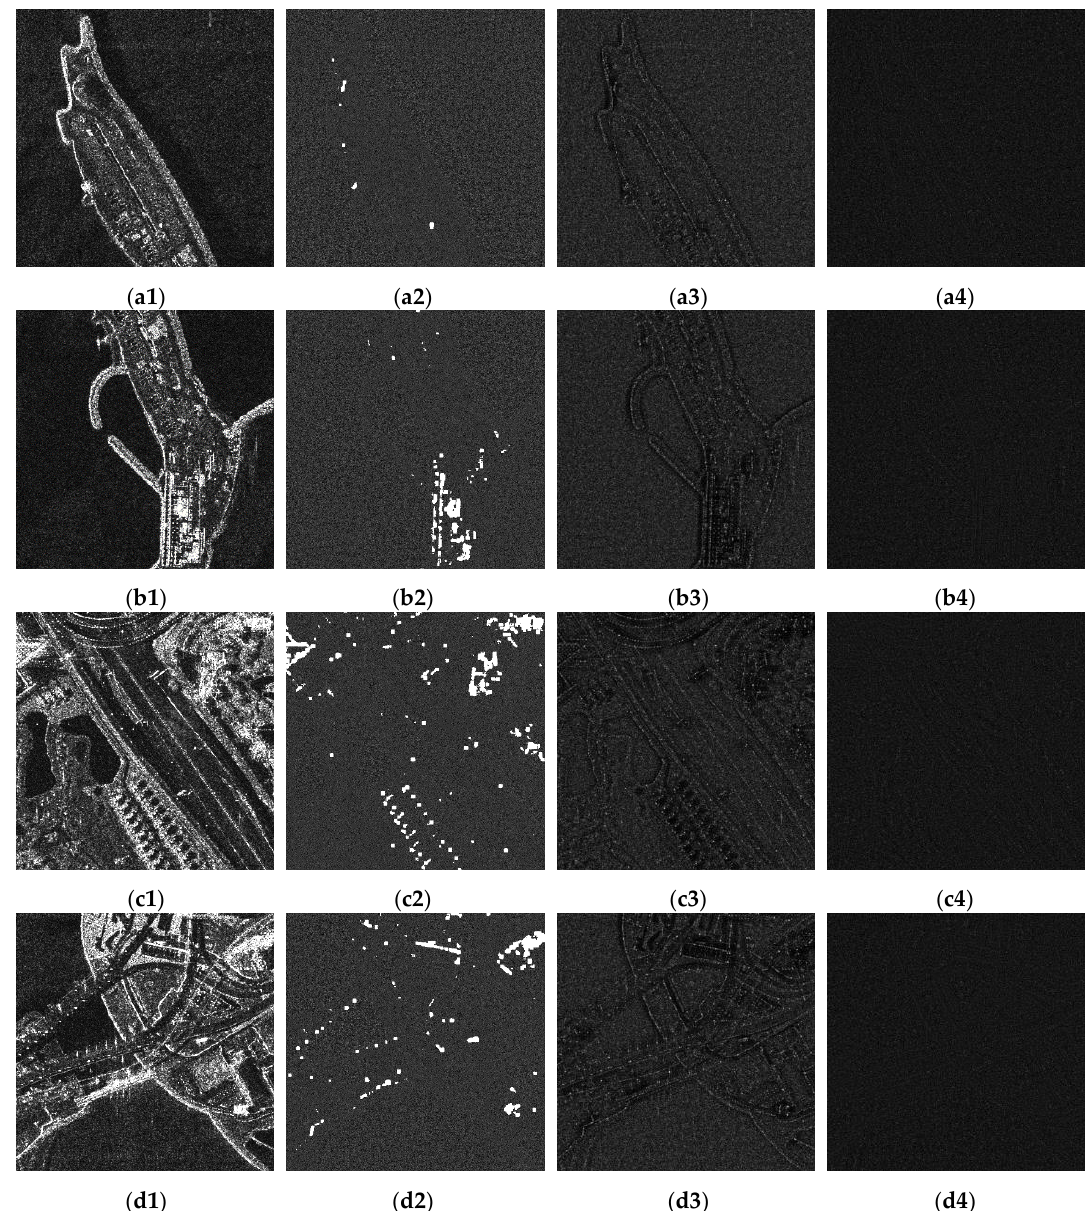
Figure 8. Despeckling results. ( a1 ), ( b1 ), ( c1 ) and ( d1 ) show raw SAR images. ( a2 ), ( b2 ), ( c2 ) and ( d2 ) illustrate results obtained by the fast non-local algorithm. ( a3 ), ( b3 ), ( c3 ) and ( d3 ) illustrate results obtained by the conventional PPB algorithm. ( a4 ), ( b4 ), ( c4 ) and ( d4 ) illustrate results obtained by the proposed three-step algorithm.